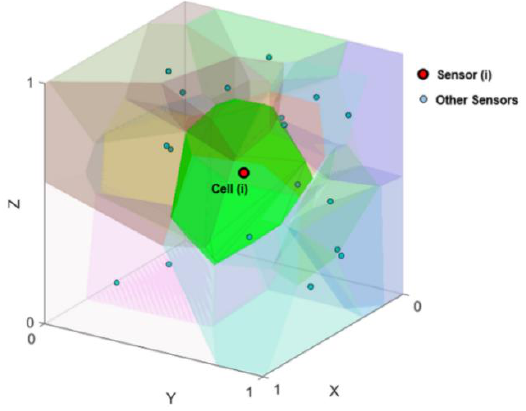
Figure 1. Voronoi diagram for sensor networks in 3D space.